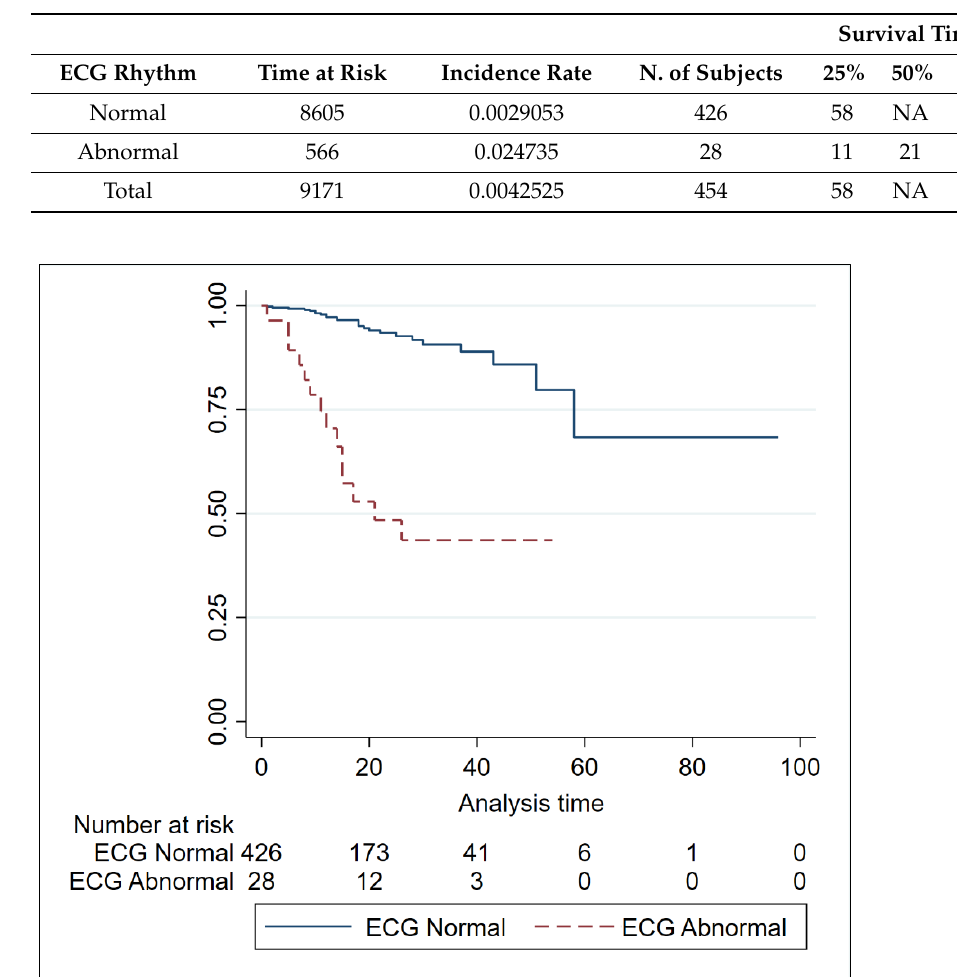
Table 2. ECG rhythm and survival.